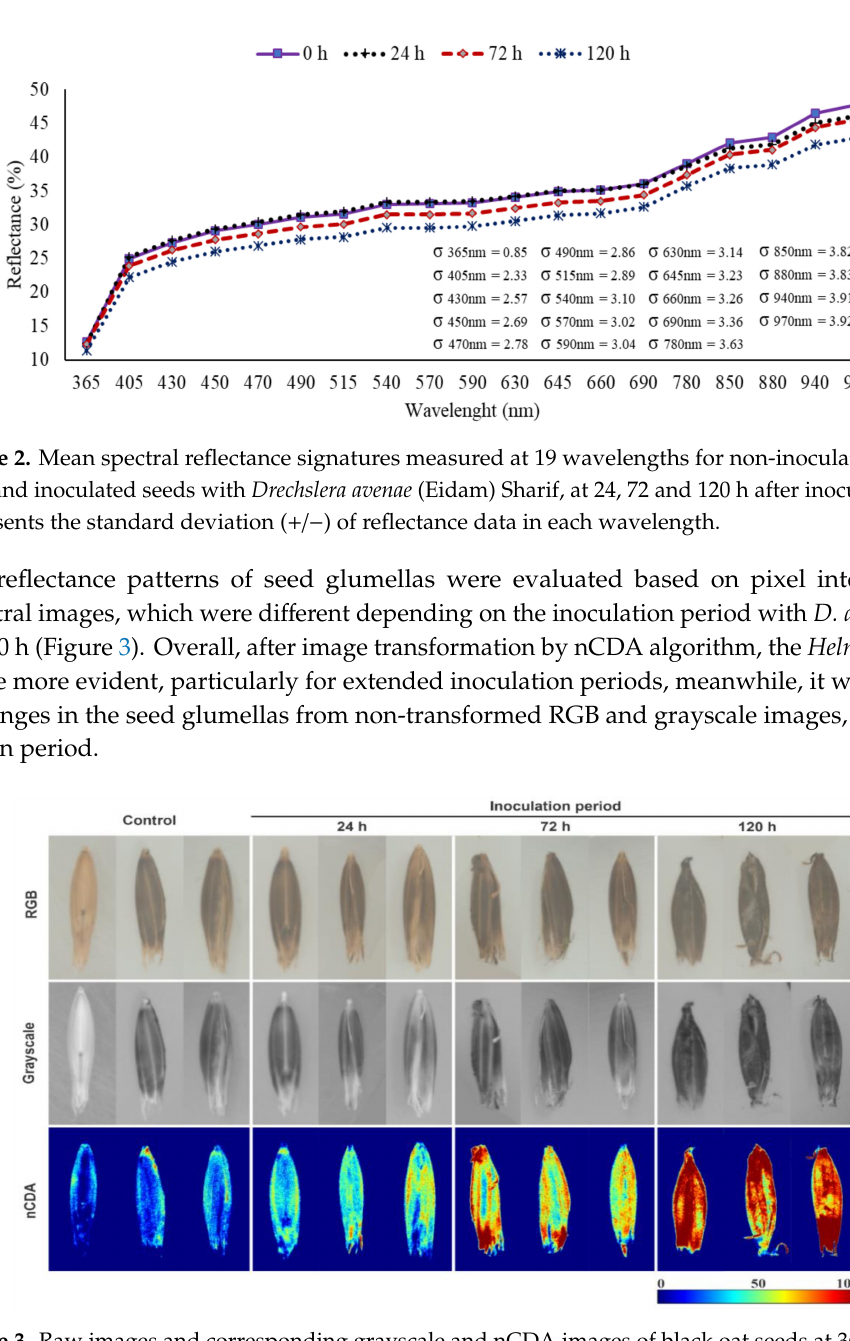
Figure 3. Raw images and corresponding grayscale and nCDA images of black oat seeds at 365 nm for fungus-free seeds (control), and seeds exposed to Drechslera avenae (Eidam) Sharif for 24, 72 and 120 h. In the images transformed by nCDA algorithm, blue color represents healthy tissues, green and yellow colors are intermediate contamination, and red color indicates higher fungal